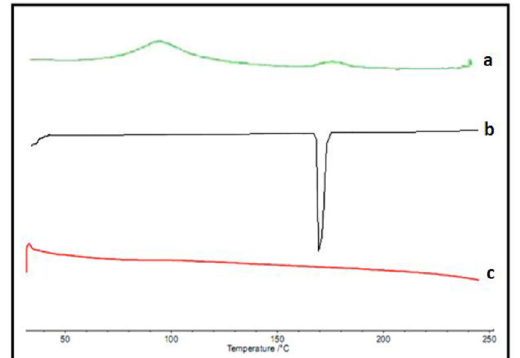
Fig.2. DSC thermograms of (a) CA, (b) acetaminophen and (c) drug-containing NFC.